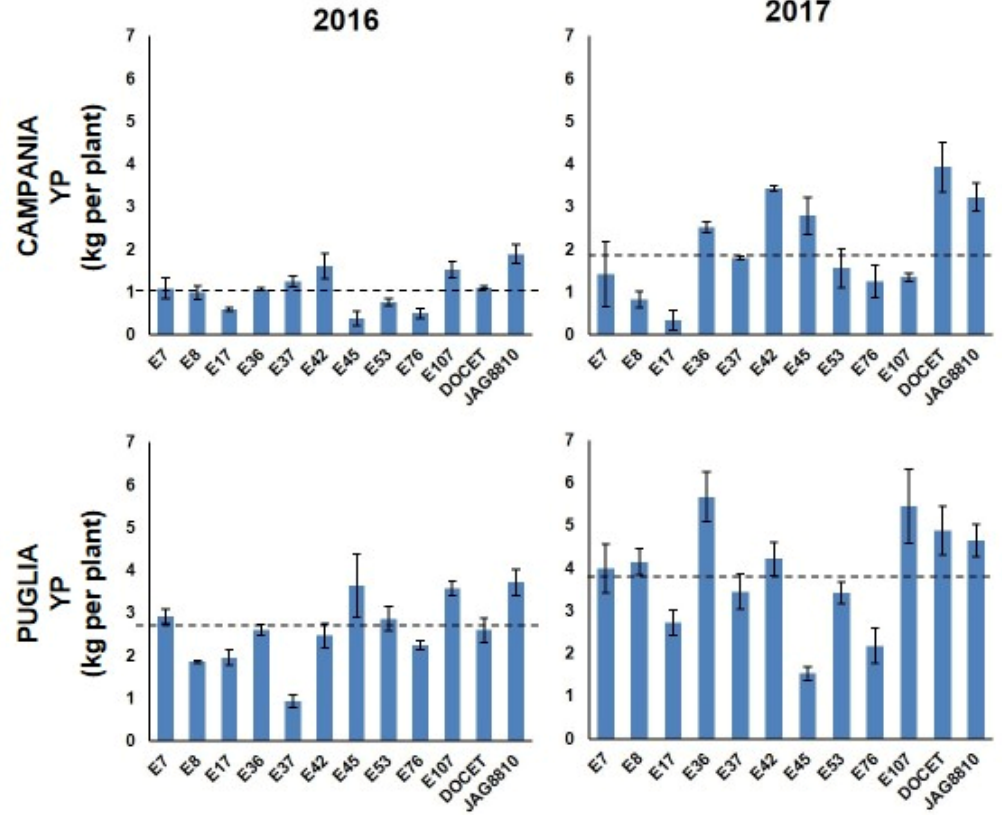
Figure 1. Yield per plant (YP) observed in the 12 tomato genotypes in Campania and in Puglia in the years 2016 and 2017. Dashed lines indicate the mean values.